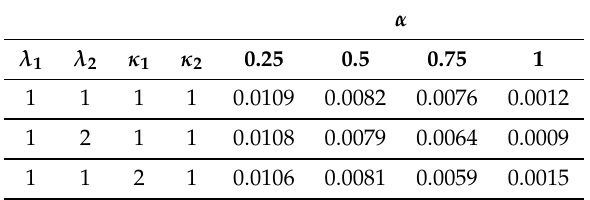
Table 4. Average absolute error generated by front-fixing